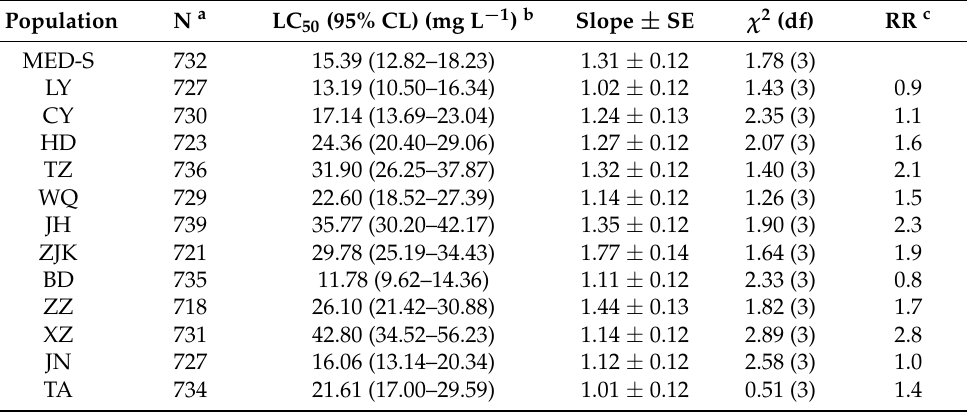
Table 1. Susceptibility to β -asarone in field-collected B. tabaci populations from China.